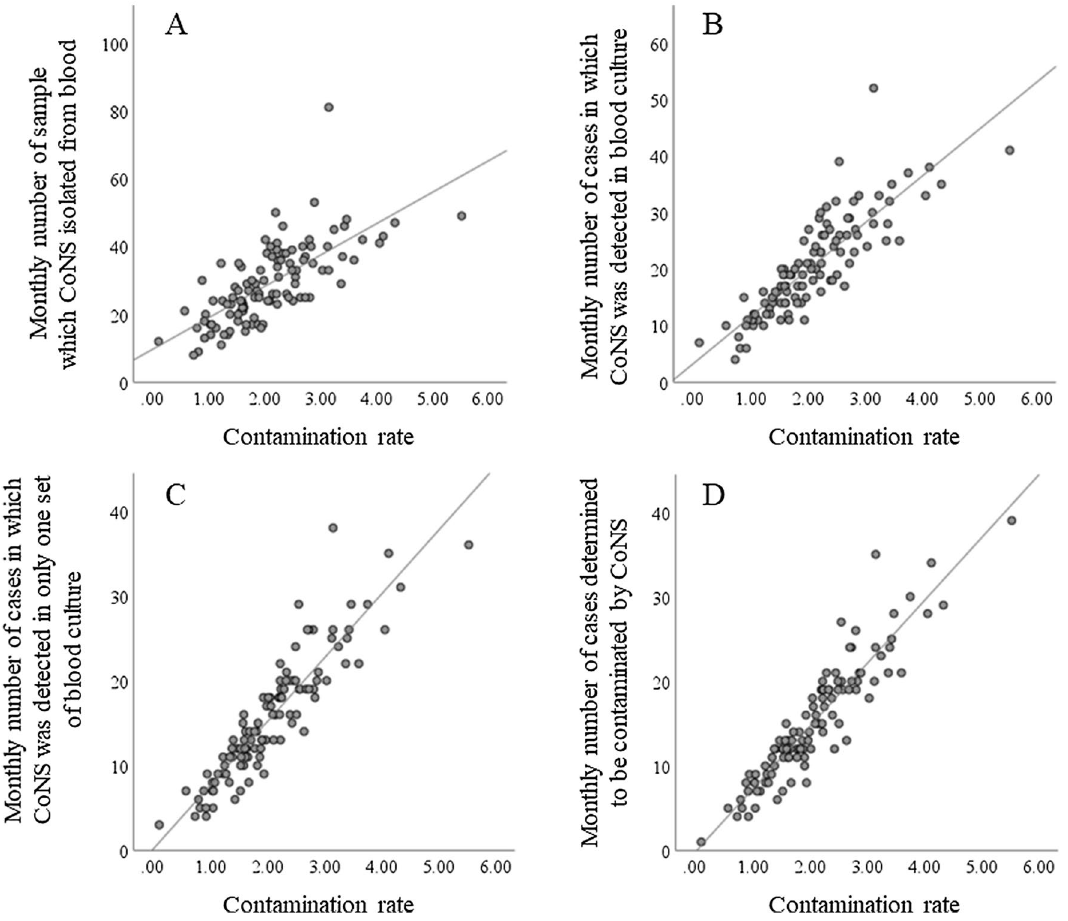
Figure 1. Scatter plot of correlation of ConR of each group (Indicator A–D). ( A ) Number of CoNS detected per specimen. ( B ) Number of CoNS detected per case. ( C ) Cases with only one set of positive CoNS. ( D )